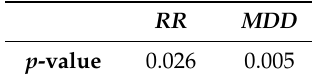
Table 11. The p -value of the conducted Wilcoxon tests of comparing the RR and MDD of IDBA and